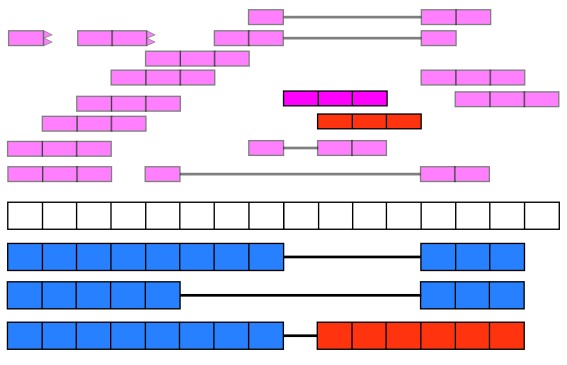
Intron retention events.Some reads might align with known intronic segments of the genome and provide information for exploring intron retention events (pink read). Some might support an intron retention event or a new isoform when coupled with exon-exon junction data (orange read).